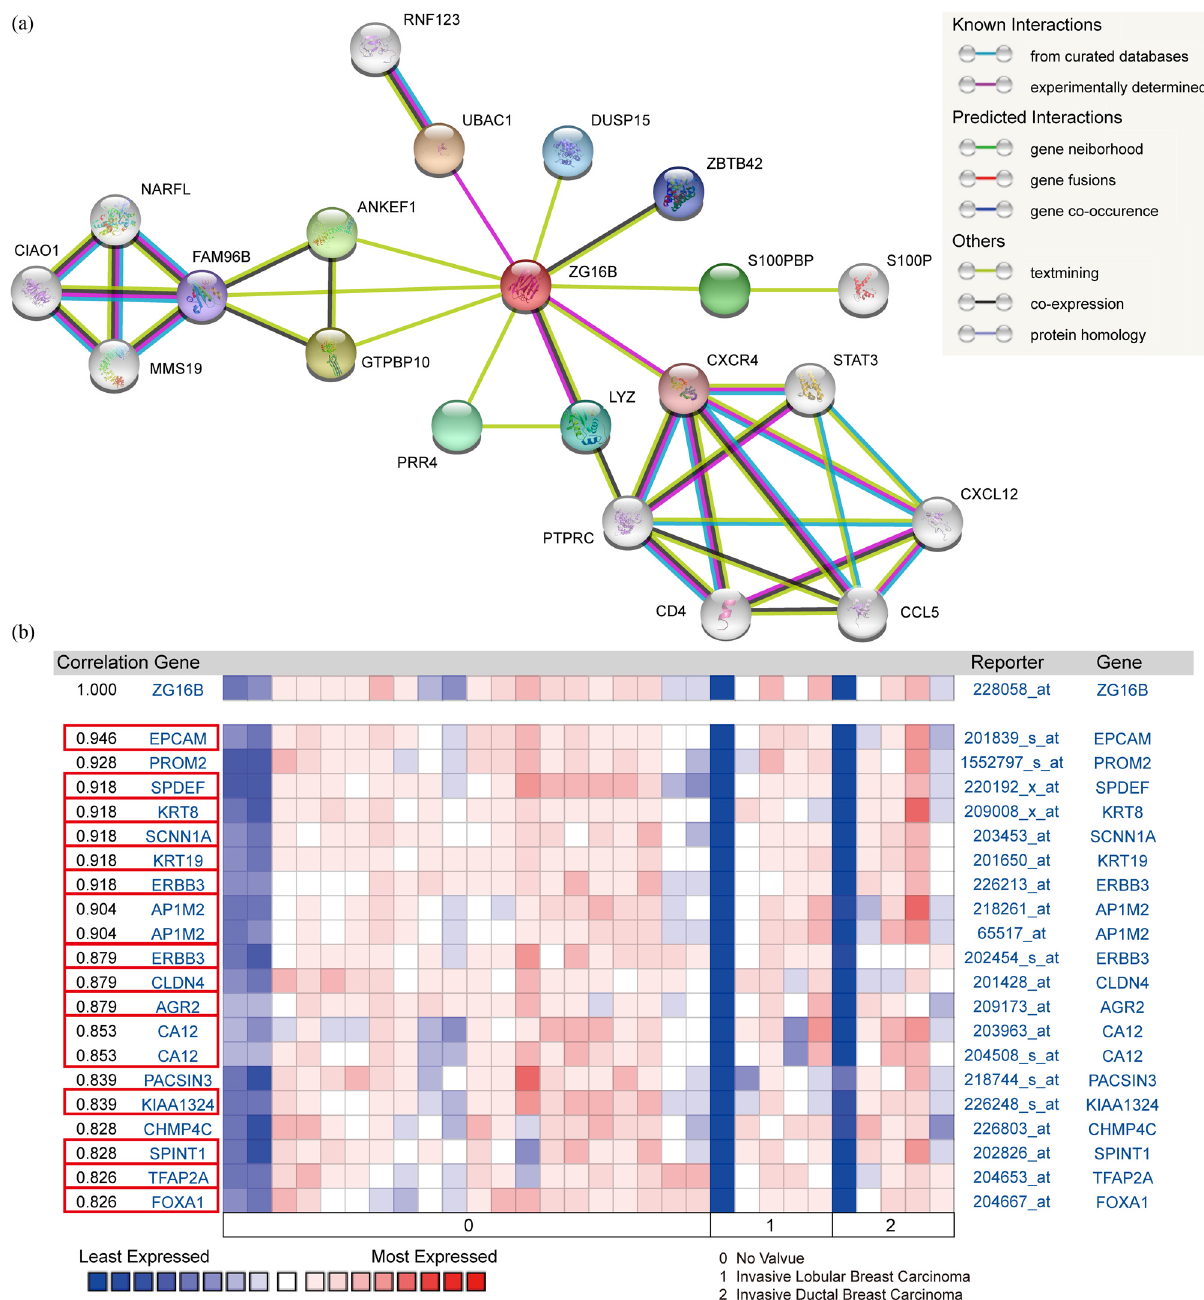
Figure 6: Protein interactions and gene co - expression analysis of ZG16B. ( a ) The protein interaction network of ZG16B was drawn by STRING analysis. The colored nodes in the network represented ZG16B and its fi rst stage of interactors, and the white nodes represented the second stage of interactors. The physical or functional relations between these proteins are interpreted in the conventional signs. ( b ) The gene co - expression analysis of ZG16B in Turashvili ’ s work was conducted by Oncomine. The co - expression genes of ZG16B in breast cancer and their coe ffi cients were marked by red